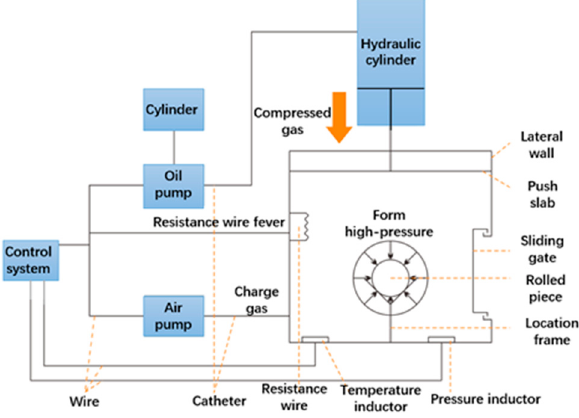
Figure 2. The principle of compacting voids in skew rolling ball by the FPM.